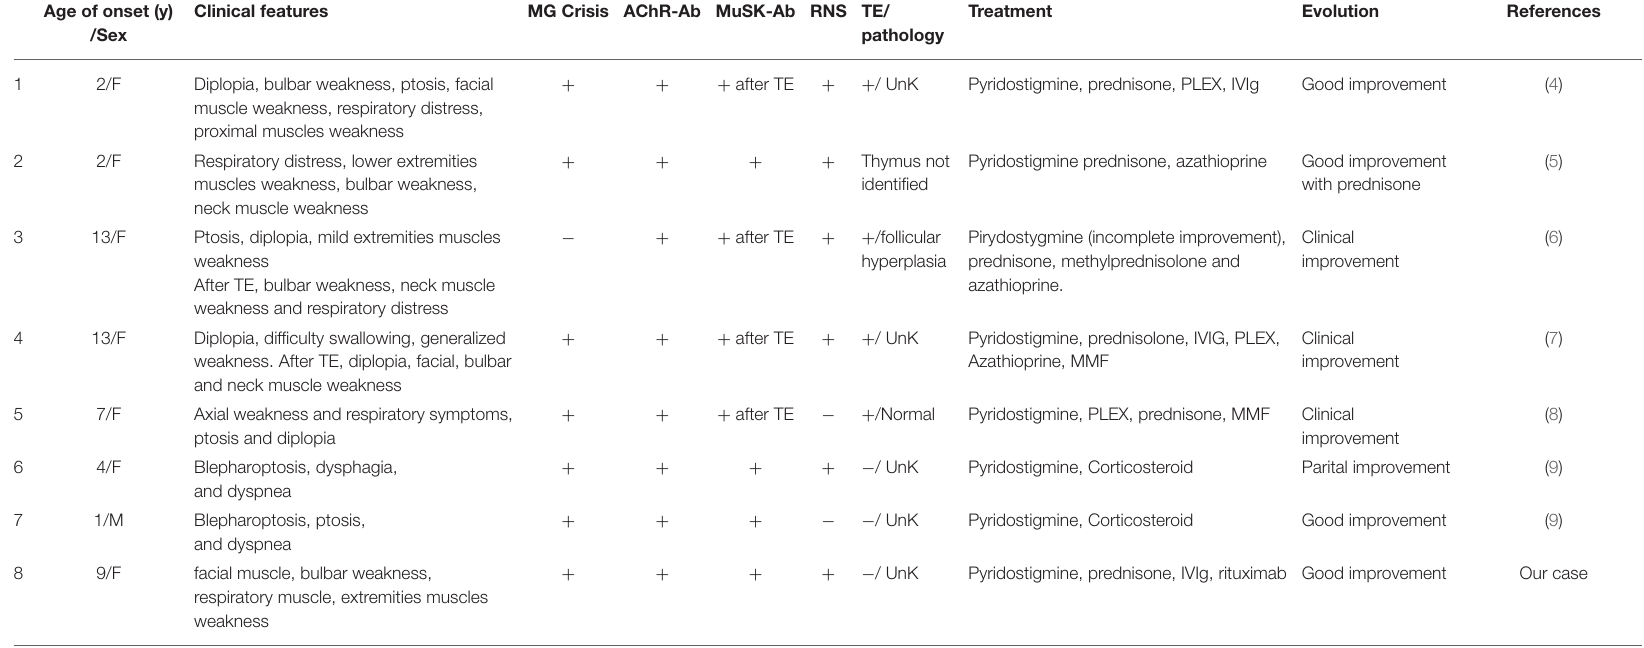
TABLE 2 | Previous reported pediatric cases of AChR +